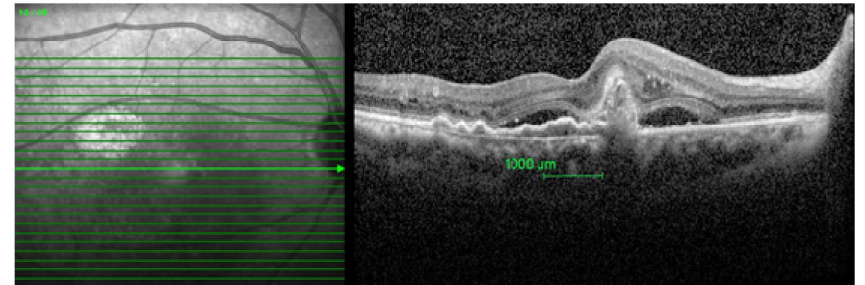
Figure 1. Central 1000-micron area selected in a study